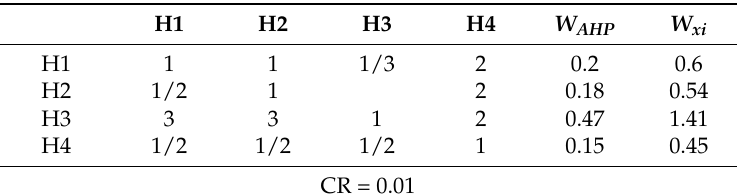
Table 3. The weights estimated from the analytical hierarchy process model and the final weights for the indicators of the hazard factor. For the definition of H1, H2, H3 and H4, see Table 2. H1